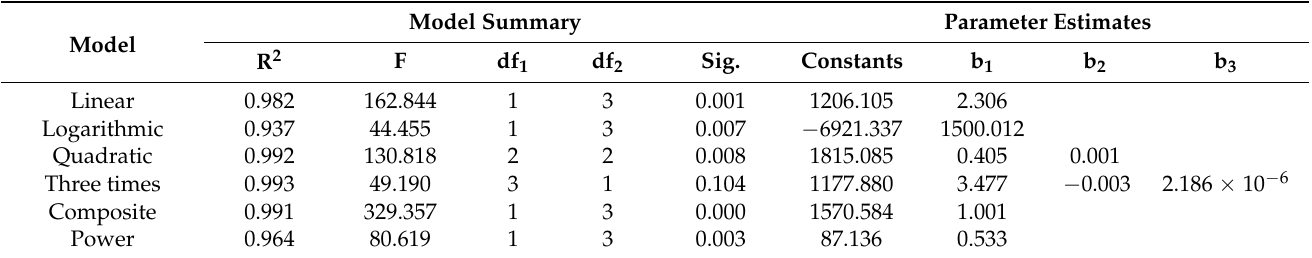
Table 8. Summary of curve estimation models and parameter estimates.